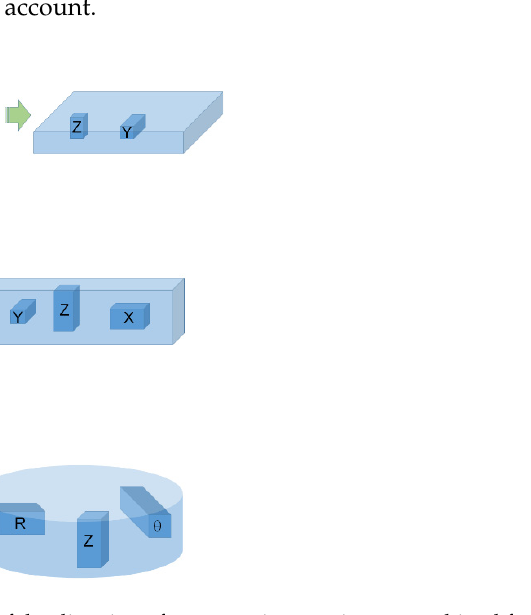
Figure 1. Illustration of the direction of compression specimens machined from the different sam- ples.